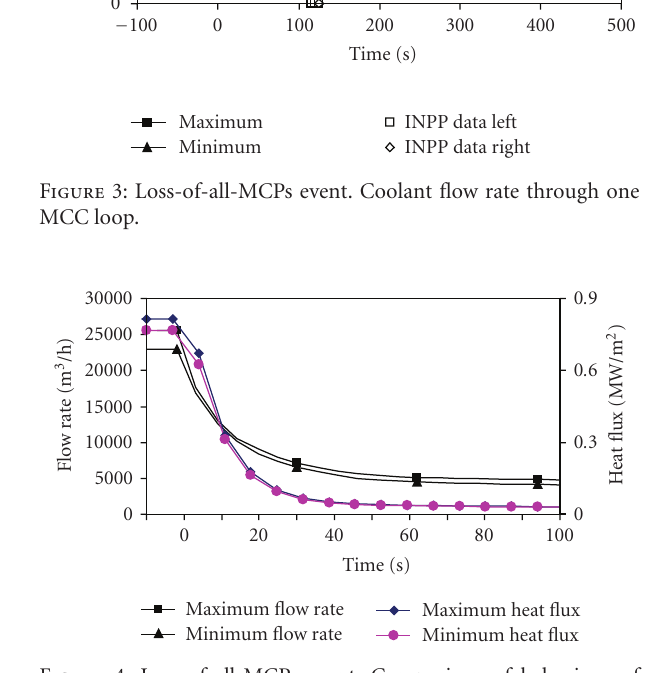
Figure 4: Loss-of-all-MCPs event. Comparison of behaviour of coolant flow rate through one MCC loop and heat flux in maxi- mum loaded fuel